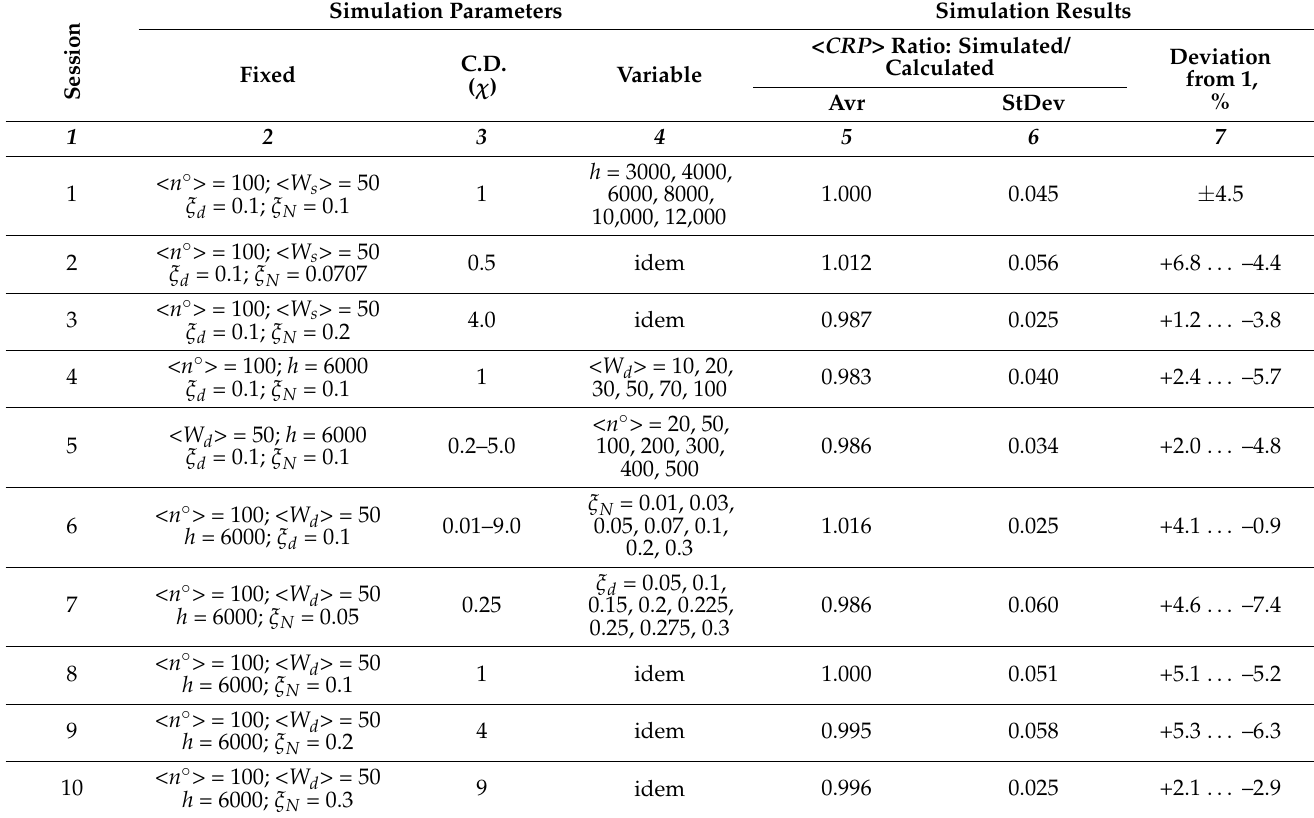
Table 1. Simulation conditions and